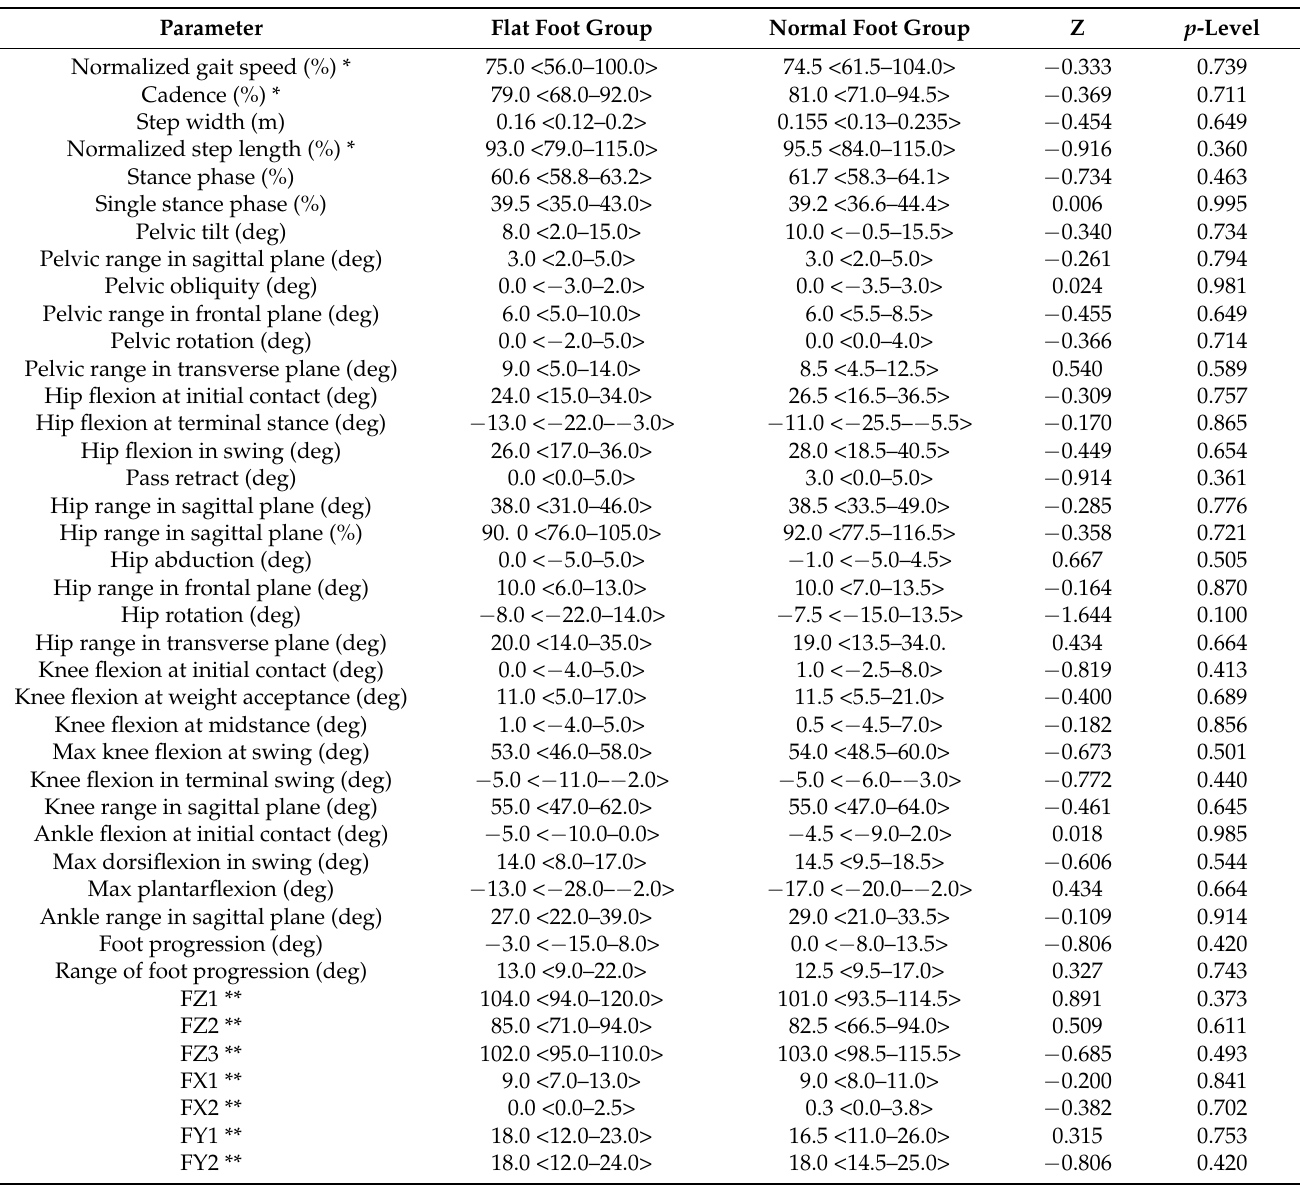
Table 2. The gait parameters when the feet were divided according to the ink footprinting. The parameters were summarized by medians and 10th and 90th percentiles. Z—the results of the Mann-Whitney U test, p -level—probability